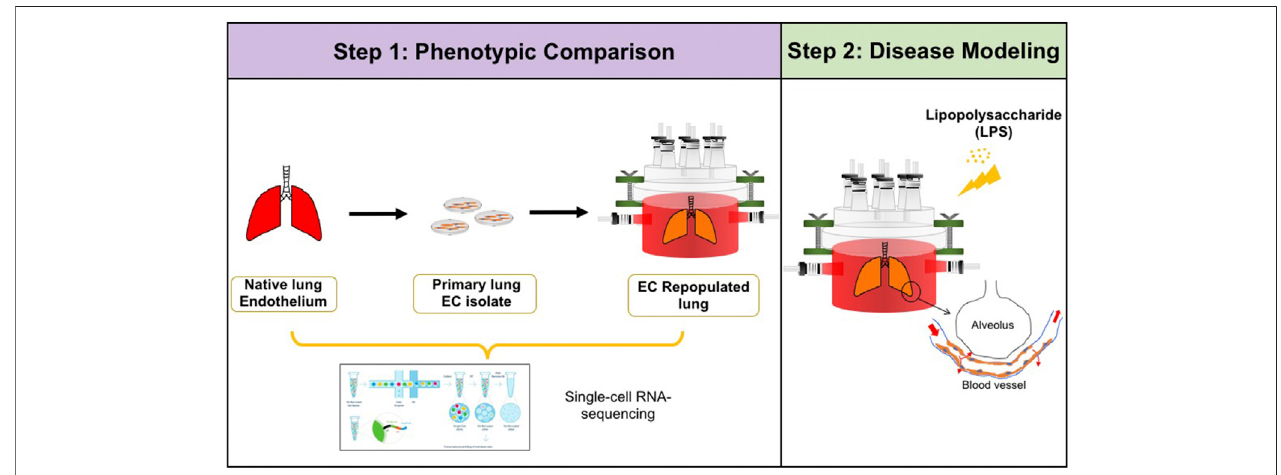
FIGURE 1 | Schematic of experimental design. Step 1: single-cell RNA-sequencing analysis was performed to compare the phenotypic and functional signals among native pulmonary endothelium, primary pulmonary endothelium cultured on tissue culture plastic, and in whole lung scaffolds. Step 2: Lipopolysaccharide (LPS) was introduced into endothelialized whole lung scaffolds to simulate in fl